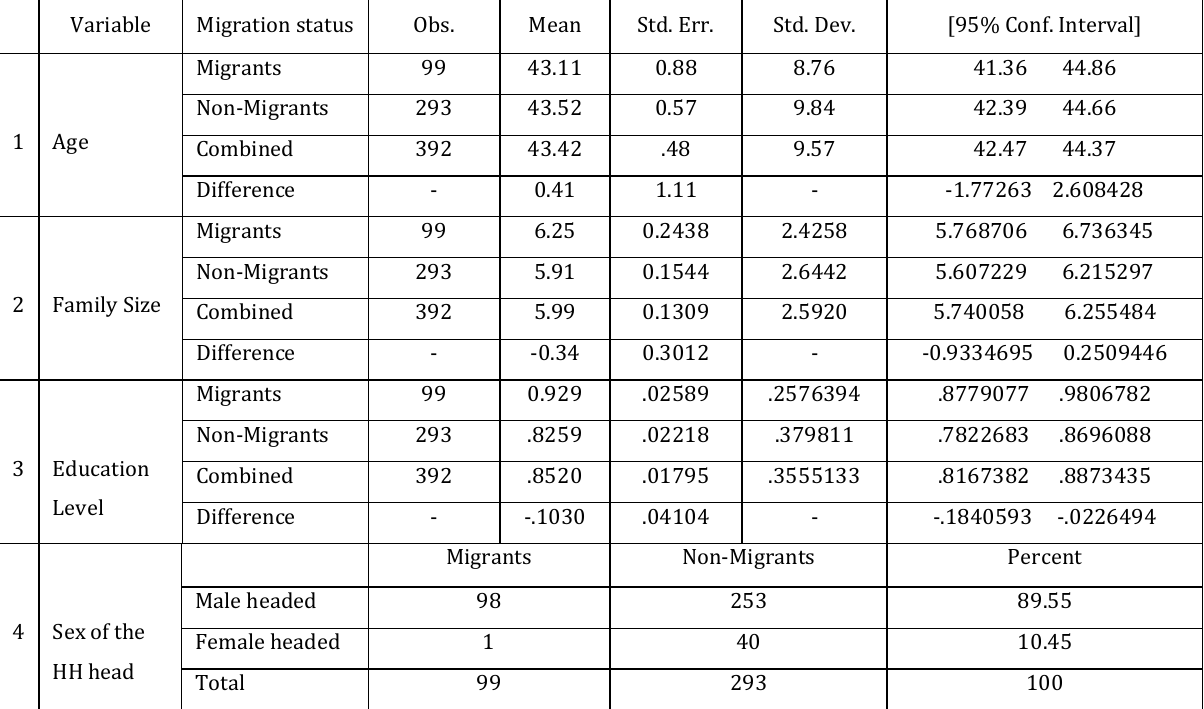
Table 3. Background information of sample respondents (Source: Own survey, 2019)